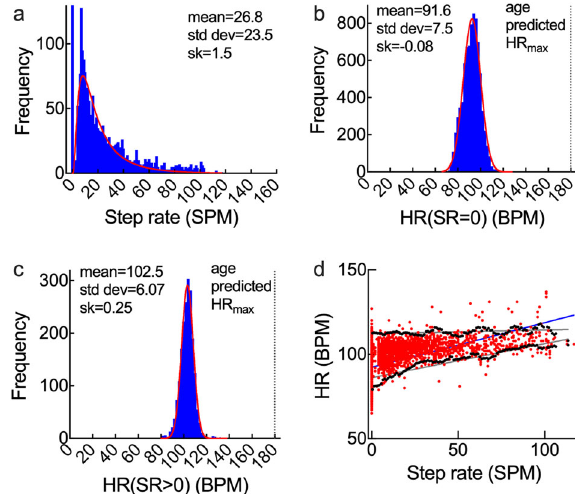
Fig. 1 Representative weekly heart rate and step rate (PAH 14/ week 11). a Distribution of minute-to-minute step rate (SR) (units: steps per minute, SPM). Red line shows a log normal fi t. b Distribution of heart rate (BPM) for all minutes where SR = 0. Red line shows a normal fi t. c Distribution of heart rate (BPM) for all minutes where SR > 0. Red line shows a normal fi t. d Weekly activity map: scatter plot showing heart rate versus step rate. Each point represents one minute where a physiological heart rate was recorded. The grey lines show the upper and lower envelopes of the activity map. The blue line shows a linear least squares fi t to the